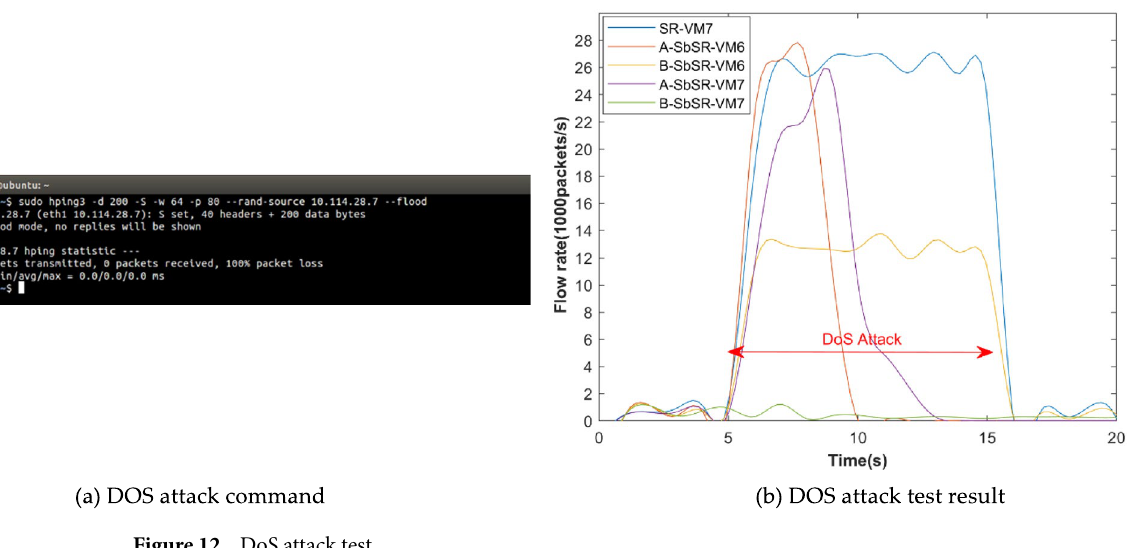
Figure 12. DoS attack